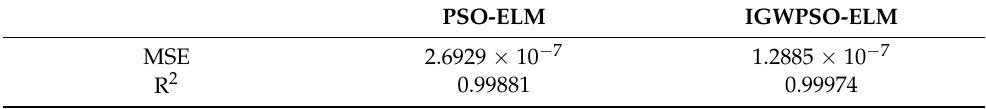
Table 2. Comparison of the prediction accuracy between PSO-ELM and